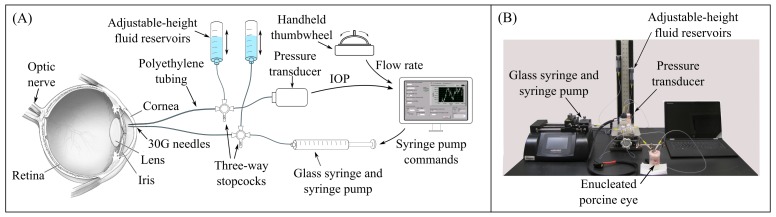
Schematic of IOP modulation system.(a) A syringe pump injected or withdrew fluid from the eye via a fine-bore needle inserted into the anterior chamber through the peripheral cornea, while a second needle connected to a pressure transducer recorded IOP. (b) Photo of system as assembled, with a cannulated enucleated porcine eye.